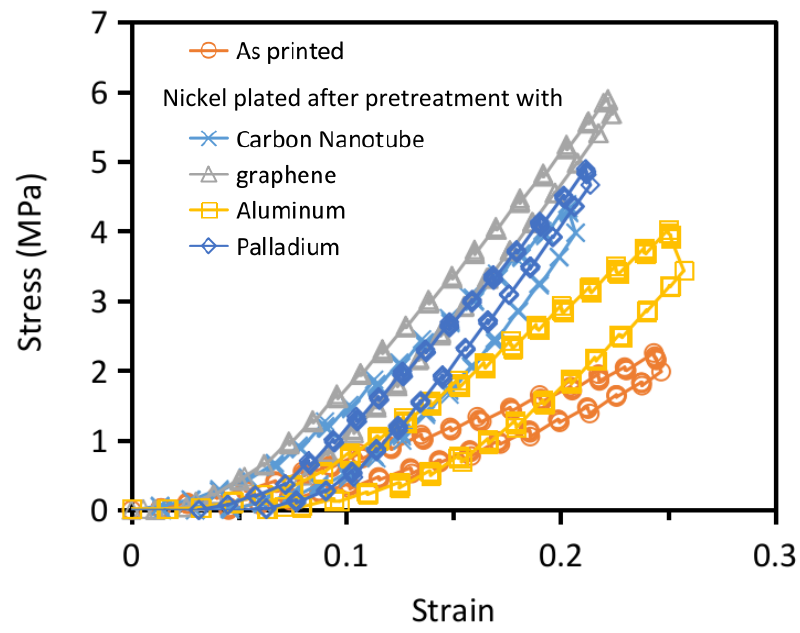
Figure 9. Comparison of the loading-unloading traces of the 130 µ m micro-lattice structures with different plating treatments. Table 5. Compressive stiffness after electroless nickel plating using different pretreatments.